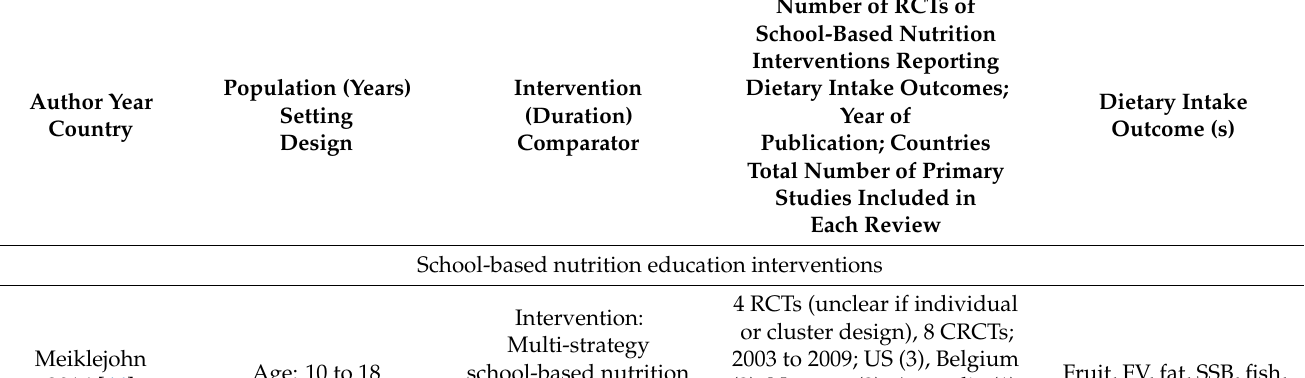
Table 1. Characteristics of included systematic reviews ( n =